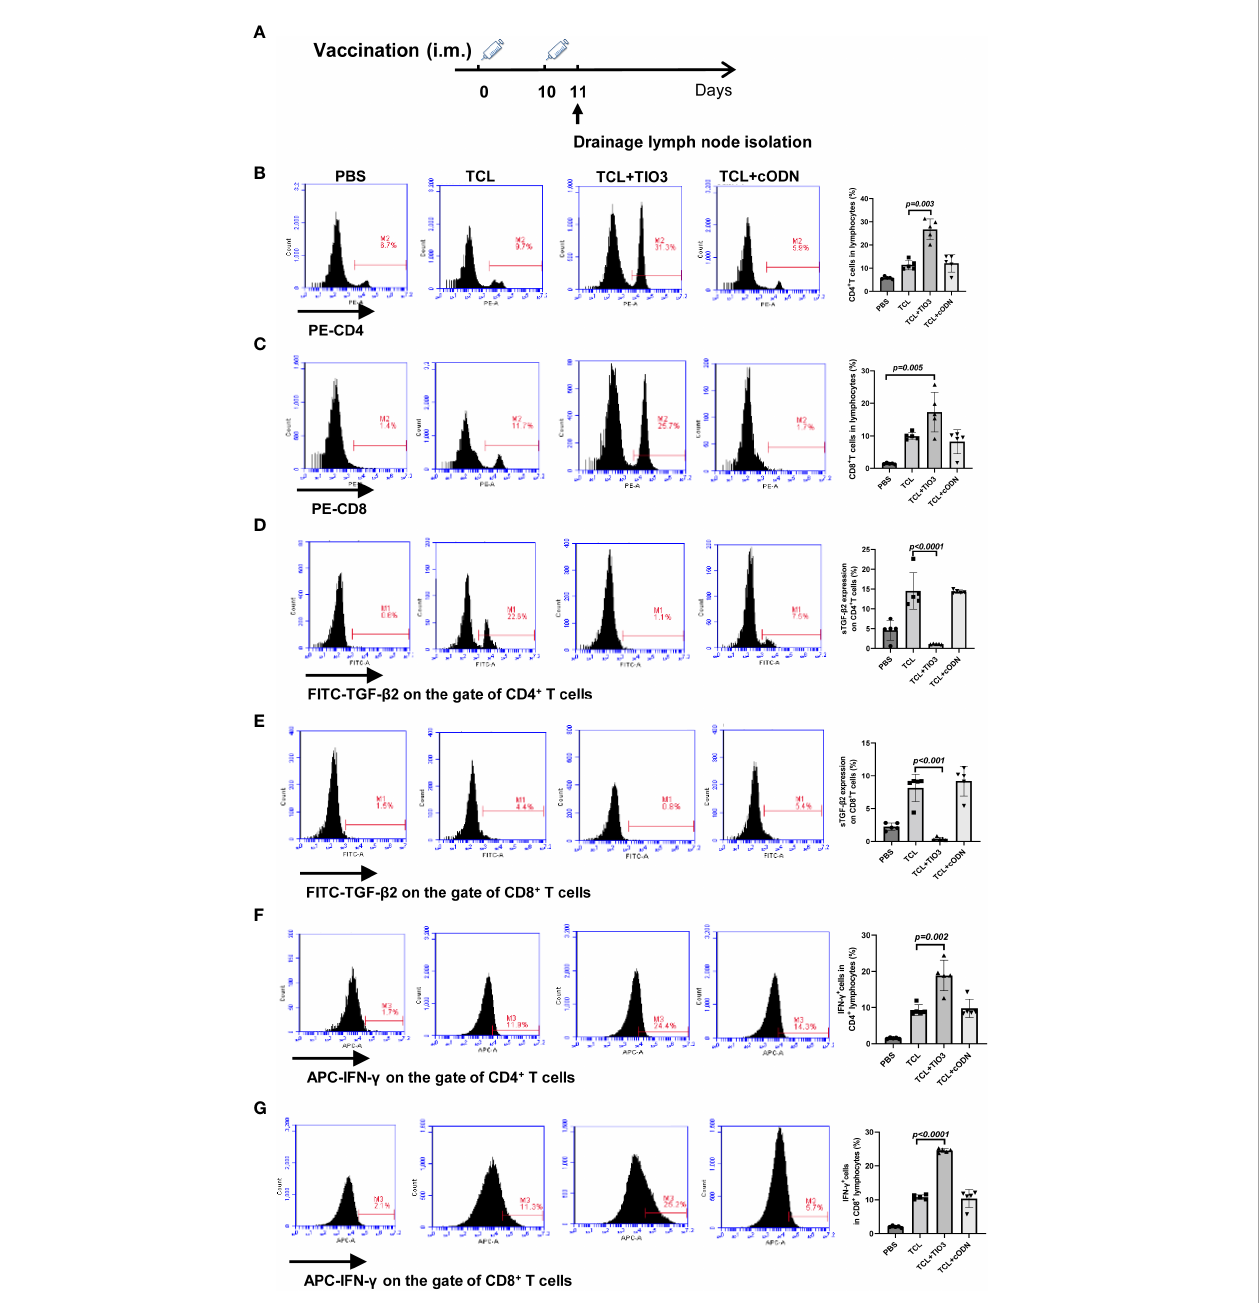
FIGURE 4 Effect of TIO3 as glioma vaccine adjuvant on the activation of T lymphocyte cells. C57BL/6 mice (n=6) were intramuscularly injected with PBS, TCL, TCL +TIO3, or TCL+cODN on day 0 and day 10, and then the lymphocytes from mouse drainage lymph nodes were isolated and analyzed by FACS. (A) Experimental procedure. (B) the percentage of CD4 + T cells; (C) the percentage of CD8 + T cells; (D-G) the expression percentage of sTGF- b 2 and IFN- g in CD4 + T and CD8 + T